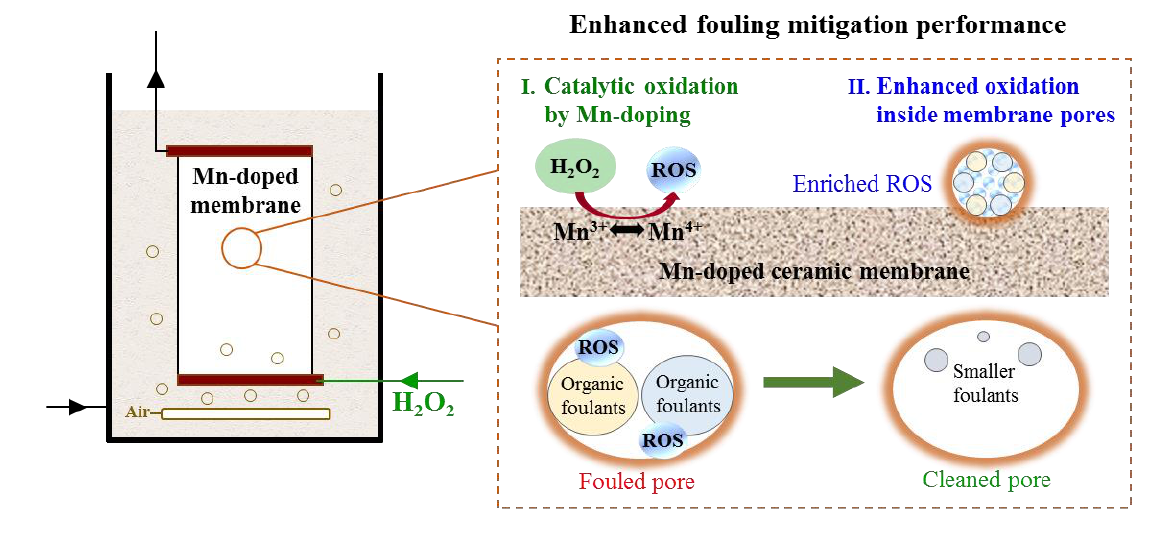
Figure 8. Schematic diagram of the enhanced catalytic removal of organic foulants within Mn-doped membrane via in-situ H 2 O 2 cleaning.